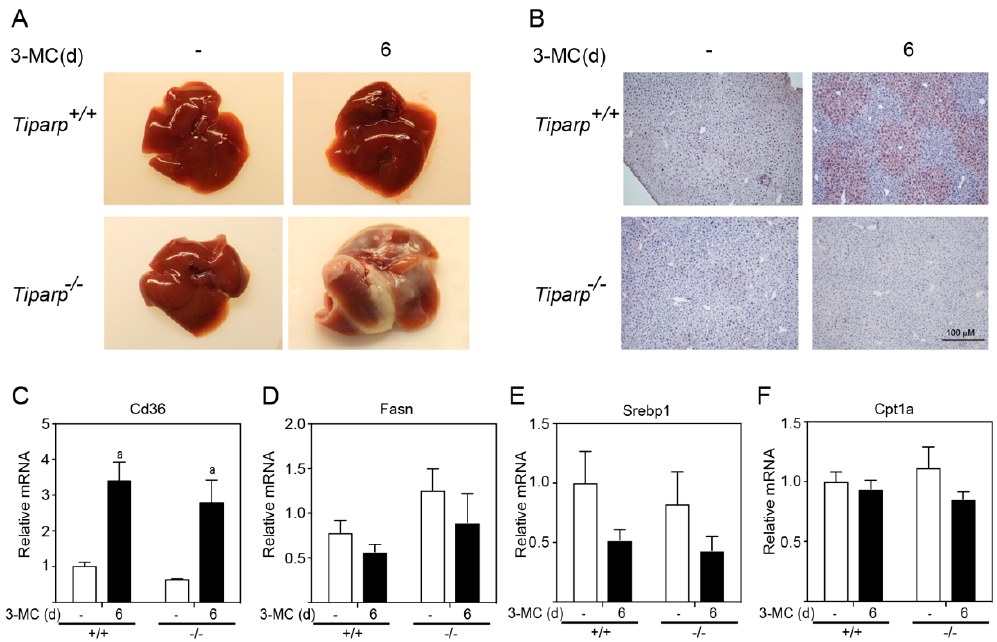
Figure 5. 3MC induces increased inflammation and inflammatory cytokine levels in Tiparp -/- compared with WT mice. ( A ) Hematoxylin & Eosin (H&E) staining of the liver lobe at day 6 after corn oil or 3MC treatment. 100× magnification. Scale bar represents 100 µm. Gene expression levels of Serpine 1 (PAI-1) ( B ), Il6 ( C ), Cxcl1 ( D ), Cxcl2 ( E ), Tnf α ( F ), and IL1 β ( G ). Data represent the mean ± SEM; n = 3 for all genes. a p < 0.05 two-way ANOVA comparison between genotype-matched corn oil- and 3MC-treated mice and b p < 0.05 two-way ANOVA comparison between treatment-matched WT and Tiparp -/- mice followed by a Tukey’s post hoc test.